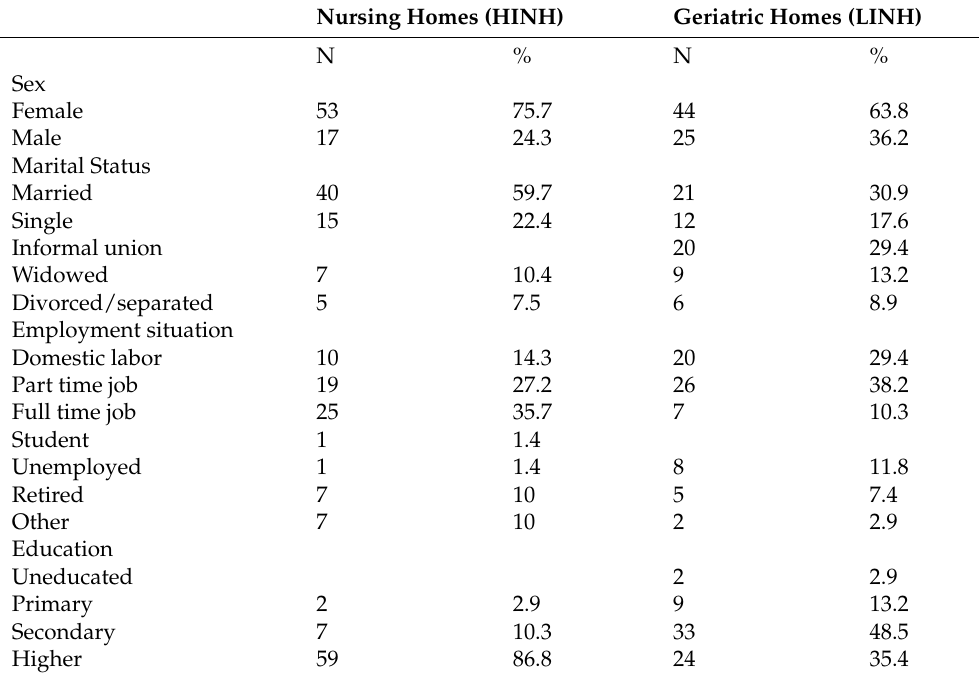
Table 1. Sociodemographic